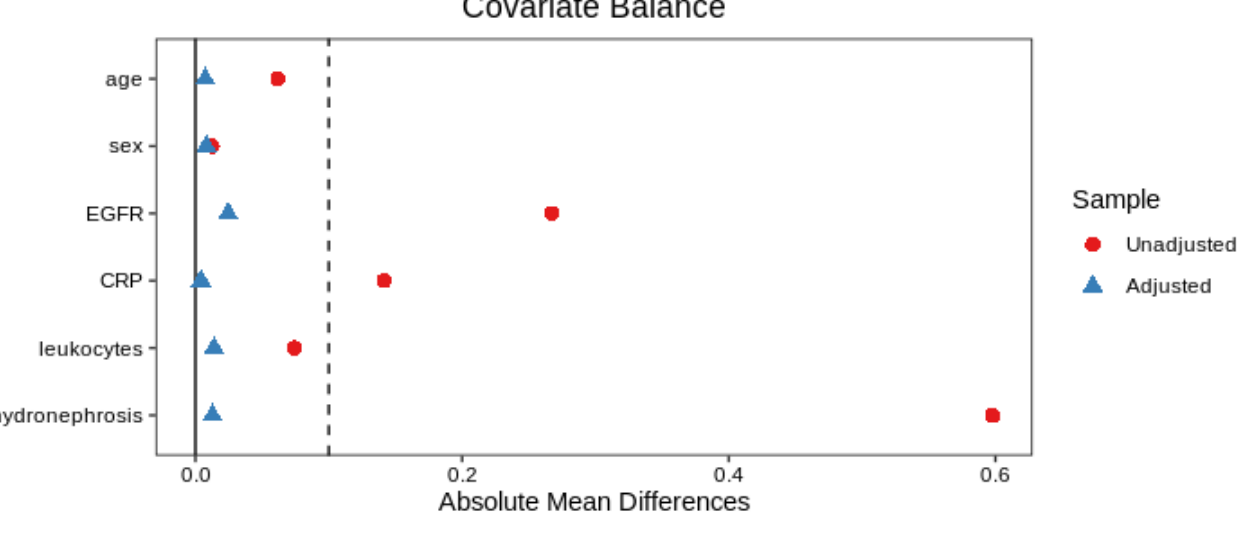
Figure 2. Standardized mean difference (SMD) in the unadjusted and adjusted with propensity score populations. CRP: C Reactive Protein. eGFR: Cockcroft estimated glomerular filtration rate.